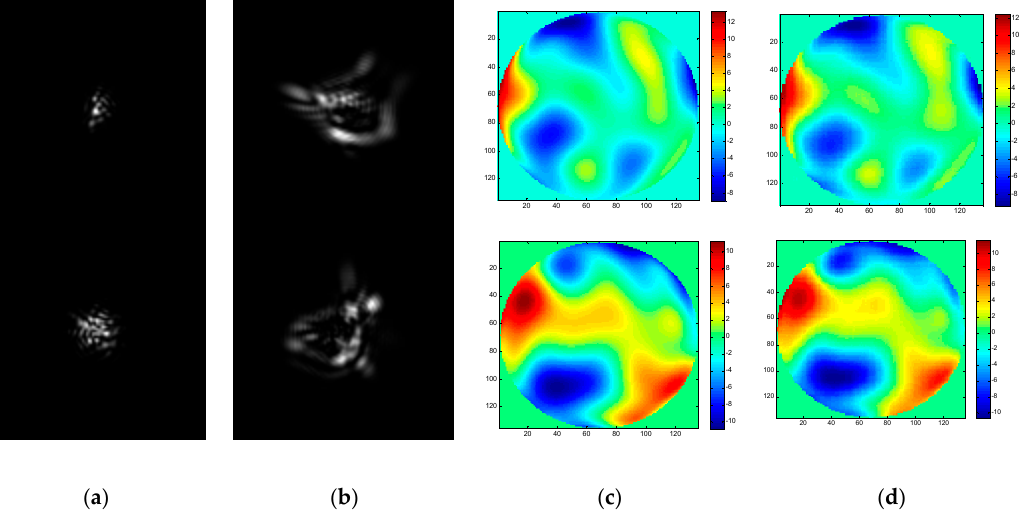
Figure 4. Predicting effect of ( a ) the initial in focus PSF images; ( b ) the initial defocus PSF images; ( c ) the initial wavefront maps; ( d ) the wavefront maps by the De-VGG predicted for D/r 0 = 15.